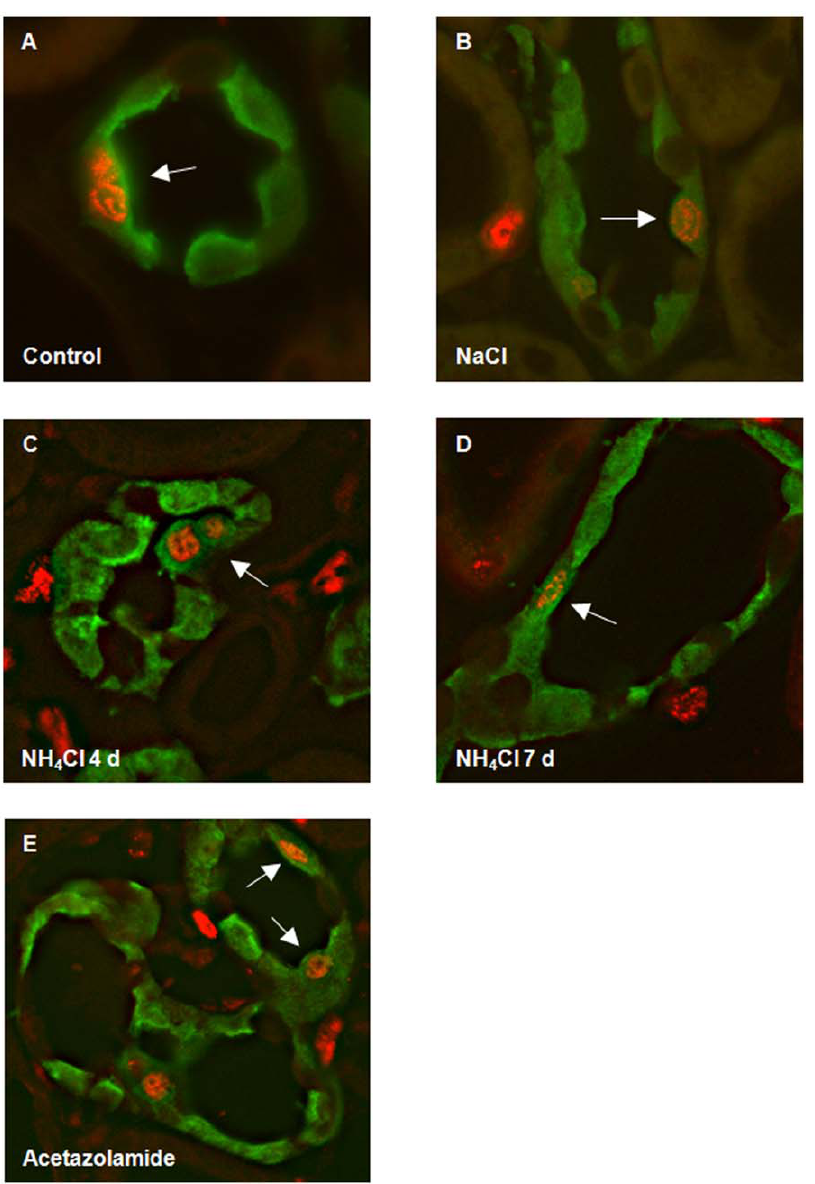
Figure 6. Proliferation of segment specific cells in the connecting tubule (CNT). Kidney sections were stained with antibodies against calbindin D28k (green), a marker of segment-specific cells in the CNT, and against BrdU (red). Colocalization of both stainings was observed in cells of animal groups in the CNT (arrows).